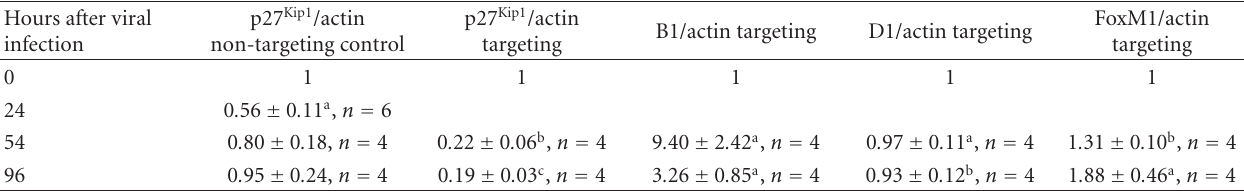
Table 1: E ff ect of p27 Kip1 silencing on the expression of cell cycle proteins in adult mouse islets. Cellular lysates of freshly isolated mouse islets and cultured islets at 54 and 96h after infection with lentivirus to silence p27 Kip1 were separated on 12% sodium dodecyl sulfate- polyacrylamide gel and electrophoretically transferred onto a nitrocellulose membrane, which was then incubated with antibodies against β -actin, p27 Kip1 , cyclin B1, cyclin D1, and FoxM1. Cellular lysates of control islets were collected at 24, 54, and 96h after infection with virus carrying non-target shRNAs for the determination of p27 Kip1 protein level. Bound antibodies were detected by using a chemiluminescence kit. The levels of cell cycle proteins were expressed as the ratio of the band density of each protein over that of β -actin of the same batch of islet proteins. The protein content of freshly isolated islets was used as the standard for comparison to express the changes in the levels of cell cycle proteins after virus infection. Data were expressed as mean ± standard error. a P < 0.05, b P < 0.01, c P < 0.005 when the indicated mean was analyzed using the single t